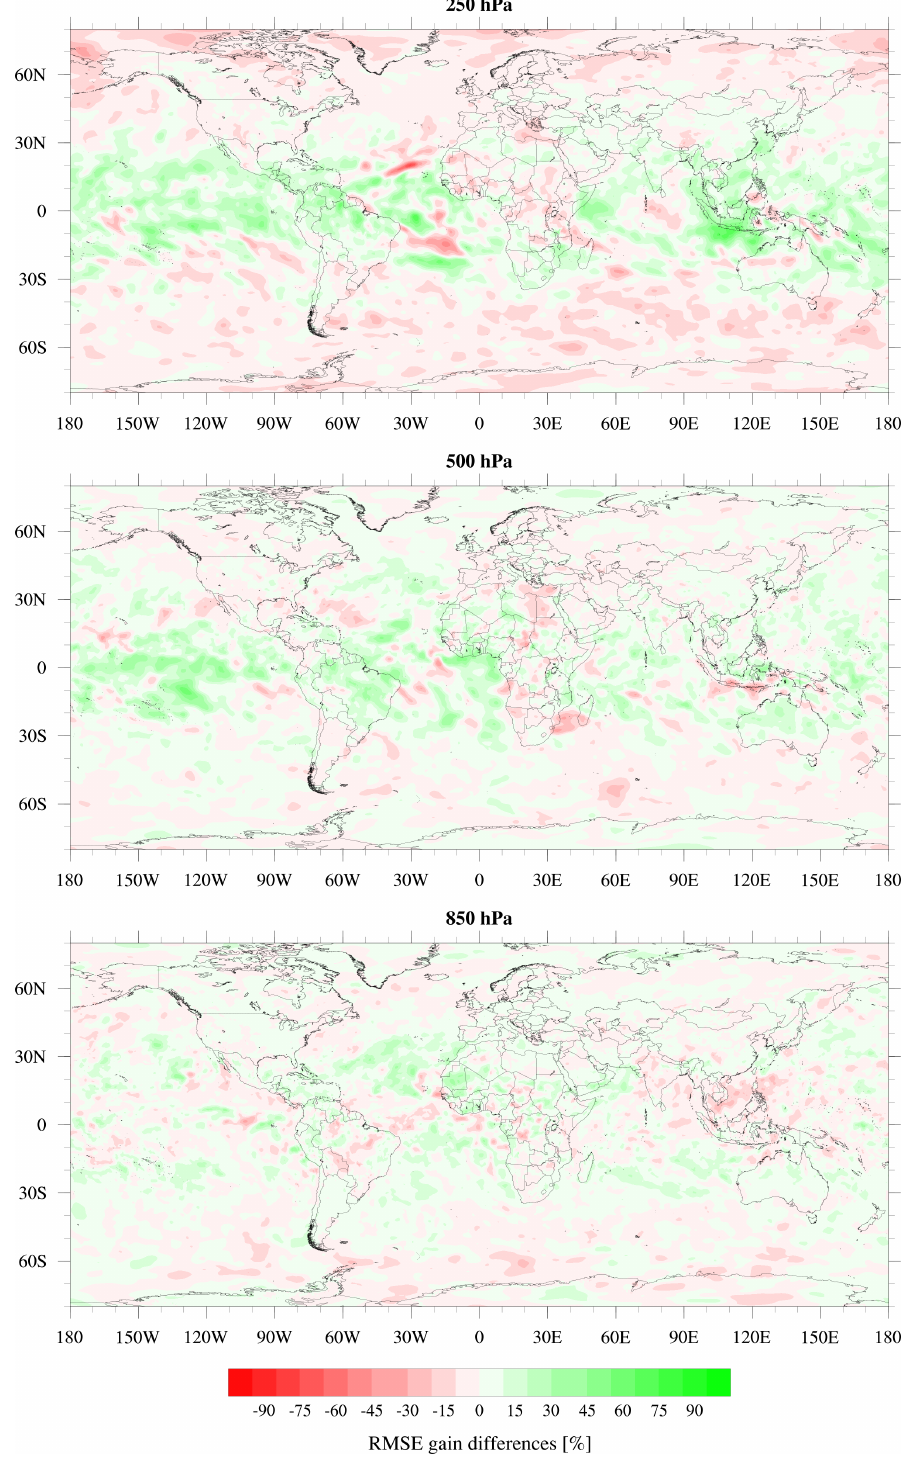
Figure 7. Mean difference in the RMSE gain between BND and REF for the 12-h temperature forecast at 250, 500 and 850 hPa (from top to bottom ), for August 2014. Green values indicate a gain in the RMSE values, while red values indicate a